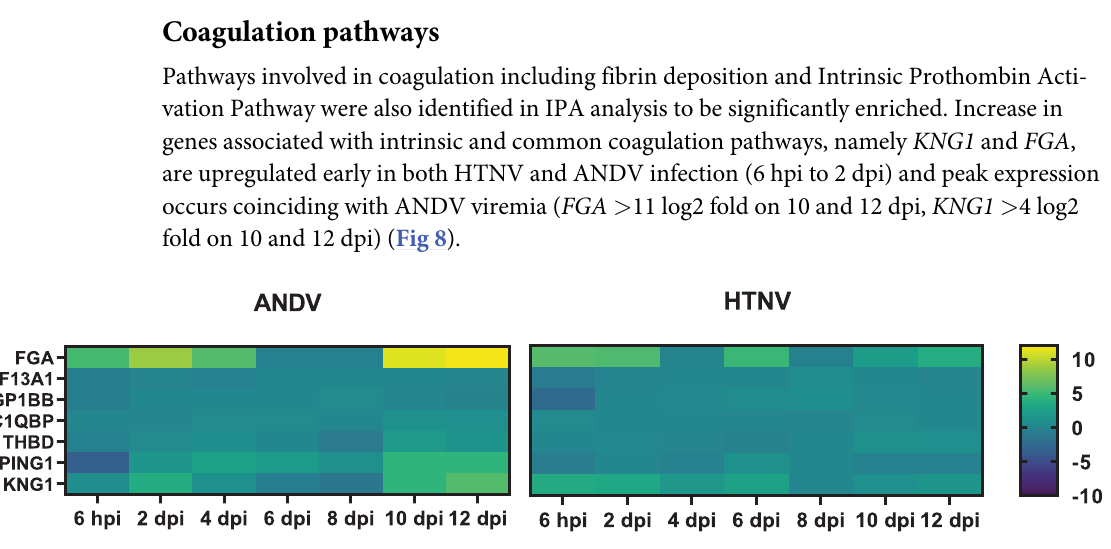
Fig 8. Coagulation Pathway Expression in Hantavirus Infected Hamsters. Genes associated with coagulation pathway expression are displayed as a heat map with hierarchical clustering and intensity of the colors corresponding to the magnitude of fold change over the baseline.